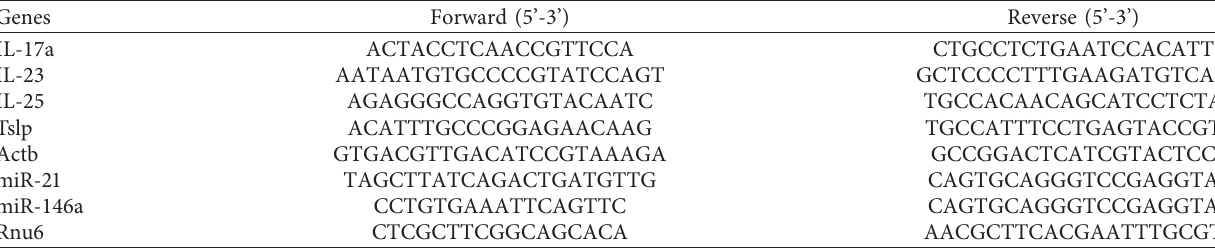
Table 1: The primer sequences for real-time PCR.